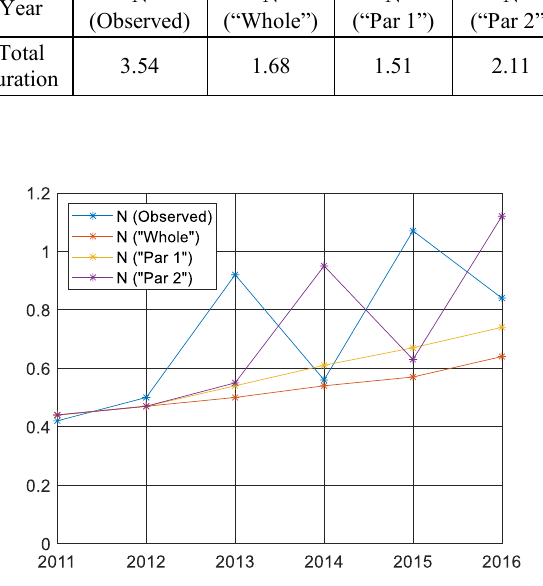
Fig. 6. Comparison between model results and observed concentrations, yearly averaged values (phosphorus). Table 6. Total Phosphorus results from model simulation, considering all pressures (total